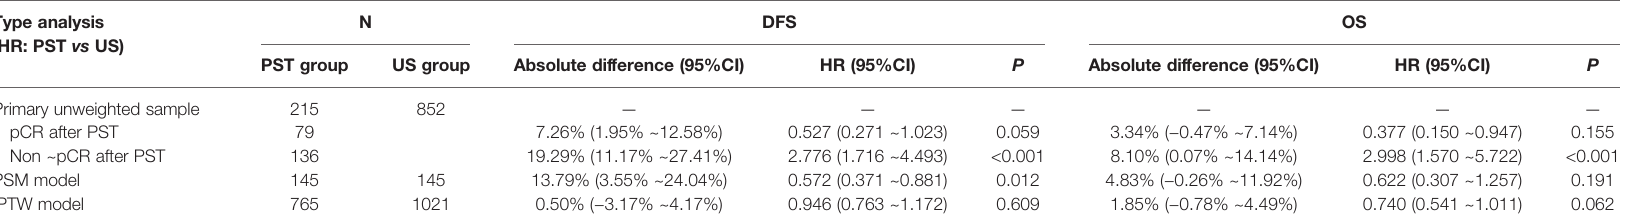
TABLE 4 | Summary of results of the survival analysis.